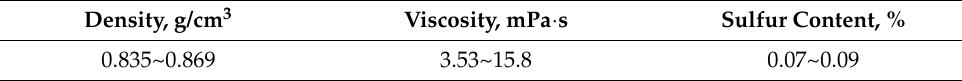
Table 3. Basic physical properties of the experimental oil. Density, g/cm 3 Viscosity, mPa ·